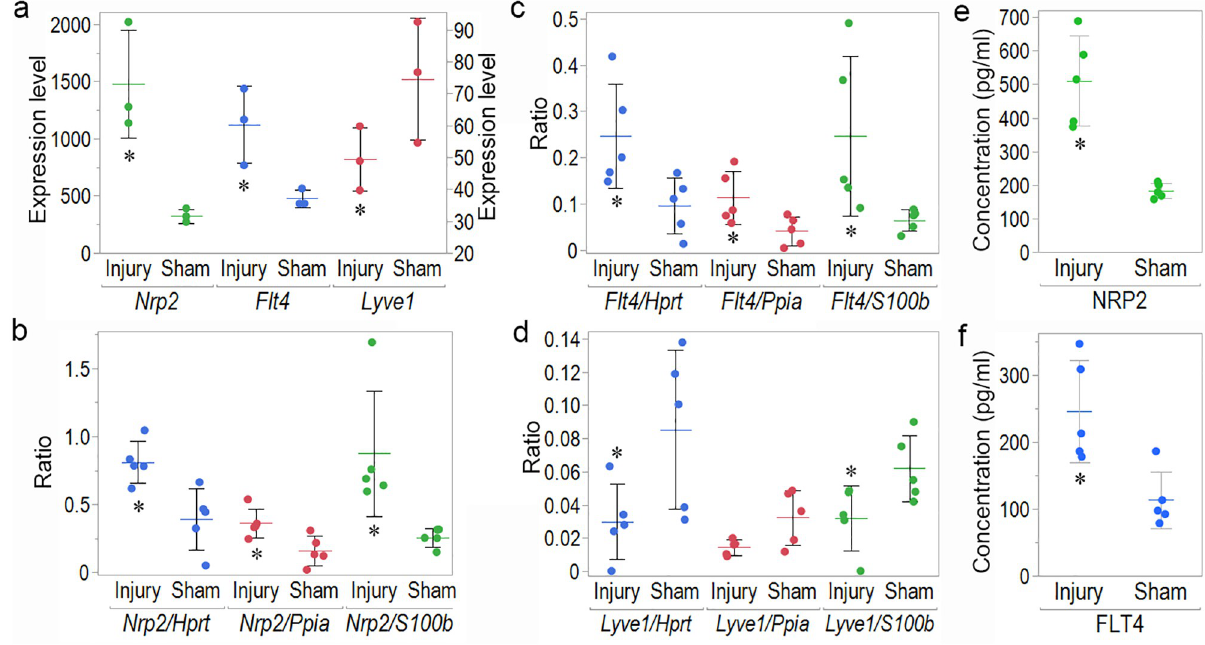
Fig 9. Microarray, RT-PCR and ELISA data for meningeal LECs from mice with injury and sham mice 3 days after injury. (a) The mRNA expression levels of Nrp2 (left Y-axis), Flt4 (right Y-axis), and Lyve1 (right Y-axis) were determined using microarrays. The mRNA expression levels of (b) Nrp2 , (c) Flt4 , and (d) Lyve1 were normalized to those of that of Hprt , Ppia , and S100b using RT-PCR. The protein expression levels of (e) NRP2 and (f) FLT4 in meningeal LECs, as determined using ELISA, were compared between the injury group and the sham group 3 days after injury. ( � p < 0.05 between injury and sham group, n = 3 for each group, as assessed using microarrays, n = 5 for each group, as assessed using RT-PCR and ELISA).